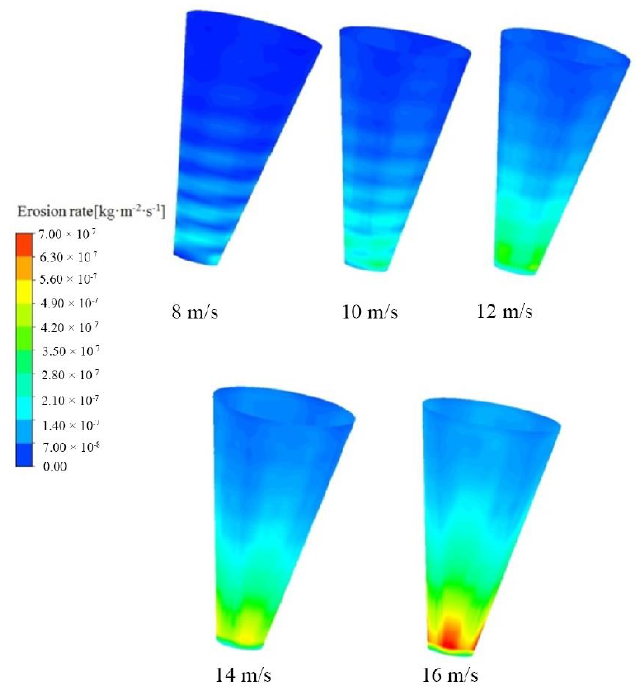
Figure 11. Erosion contour with different cone velocities.